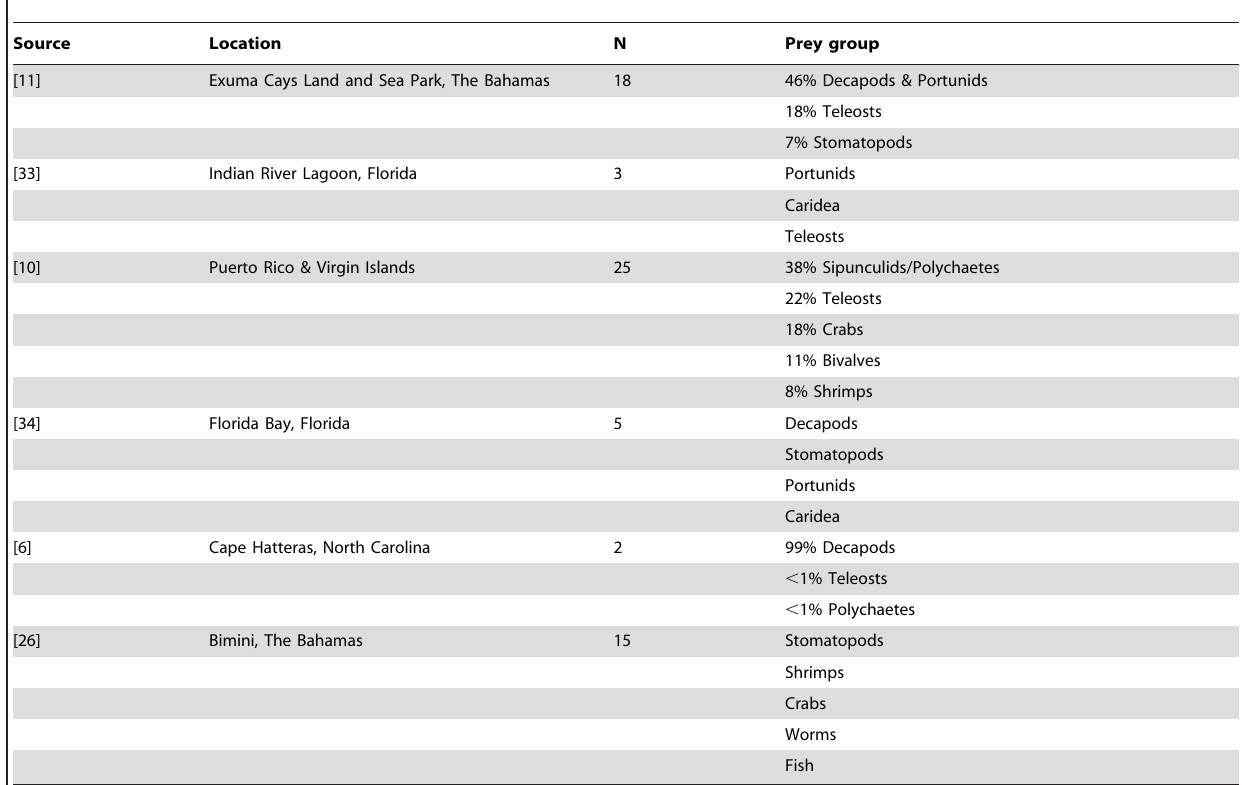
Prey groups are listed in order of decreasing proportional volume where data available. Unnumbered prey indicates prey proportions were not ranked. Column N represents the number of rays sampled in each study.